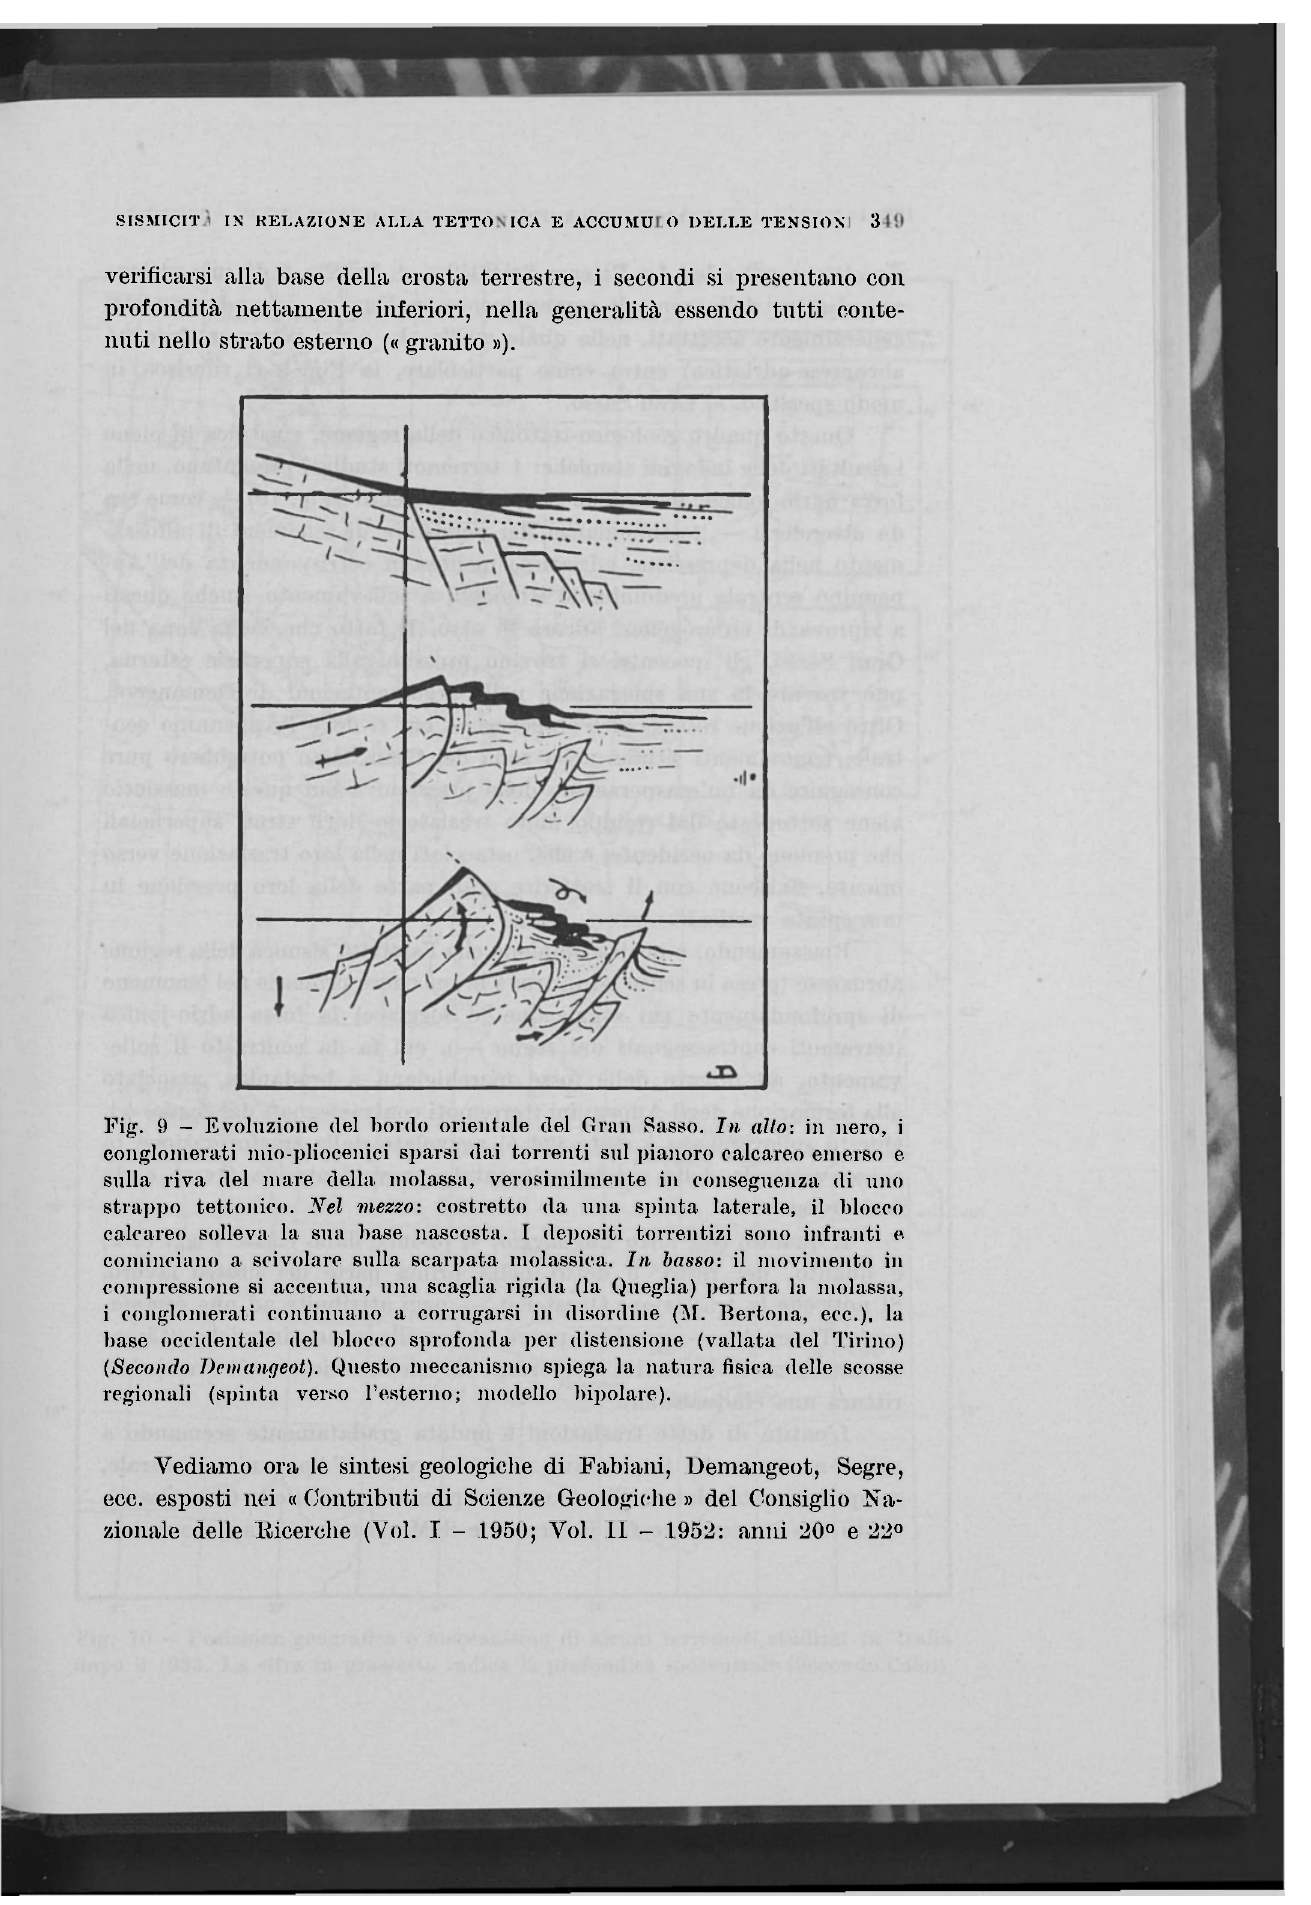
Fig. 9 - Evoluzione del bordo orientale del Gran Sasso. In alto: in nero, i conglomerati mio-pliocenici sparsi dai torrenti sul pianoro calcareo emerso e sulla riva del mare della molassa, verosimilmente in conseguenza di uno strappo tettonico. Nel mezzo : costretto da una spinta laterale, il